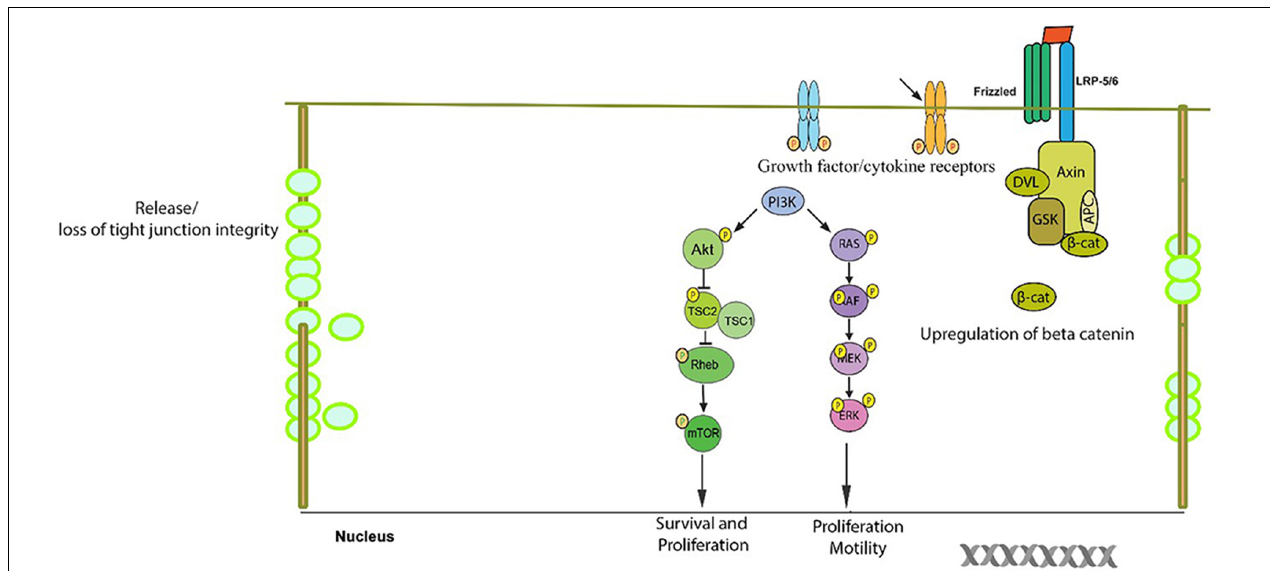
FIGURE 2 | Schematic/proposed signaling model in a cell during tumor formation. Aberrant change in signaling pathways result in the resistance of the normal cellular apoptosis and/or senescence in a cell which is destined to be a tumor cell. The anti-apoptotic proteins belonging to the bcl2 family are upregulated. The tight junction complex changes its course of normal function of selective permeability to unrestricted flow to various unintended solutes/growth/cytokine factors which may be responsible in up regulation of survival signaling pathways. The expression and/or phosphorylation of growth factor/cytokine receptors which promote cell growth are enhanced. The PI3-K/Akt pathway, which is a survival pathway, becomes activated along with the RAS-RAF-ERK pathway and Wnt/beta-catenin pathway which result in the up regulation of several growth response